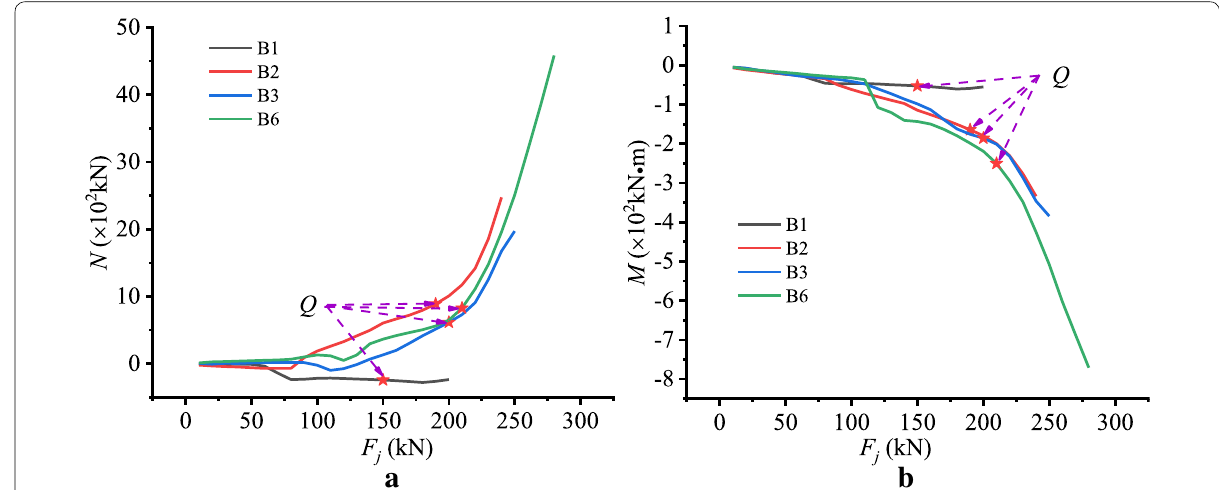
Fig. 15 The internal forces of the different RC beams: a the bending moments of the RC beams with different concrete strength; b the axial forces of the RC beams with different concrete strength.